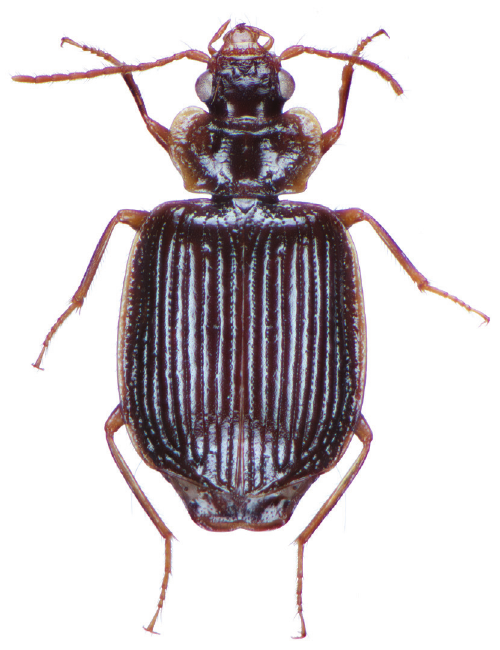
Figure 73. Dorsal habitus and color pattern of Formosiella brunnea Jedlička. (OBL 5.50 mm).